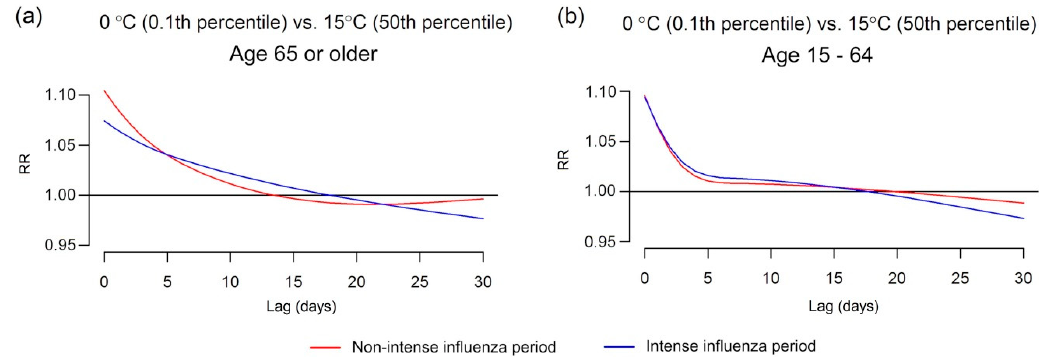
Figure 6. The extreme cold effect on IHD deaths on intense and non-intense days among ( a ) age 65 or older and ( b ) age